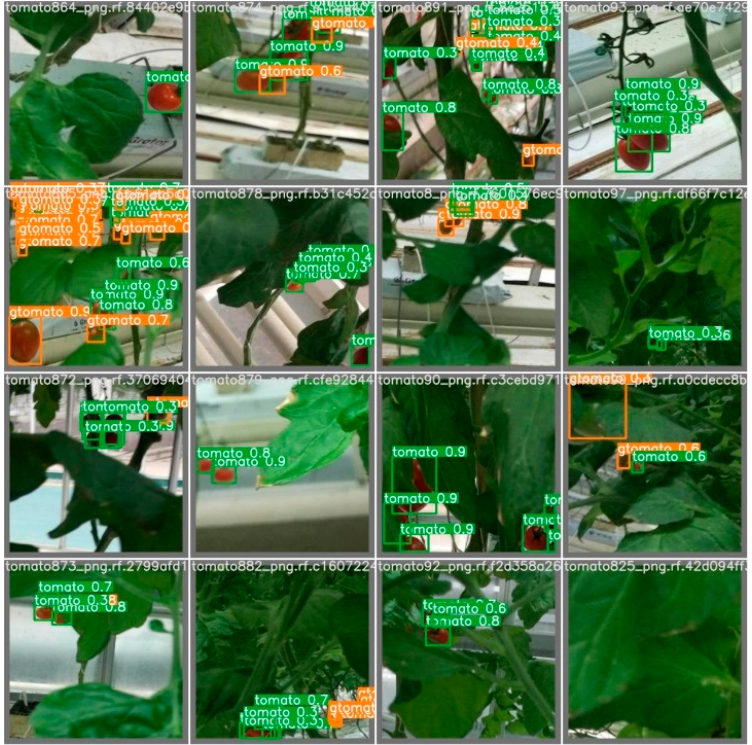
Figure 11. Obtained test results batch with accuracy for Tomato detection model. Here, green and orange colored bounding boxes represent red tomato and green tomato classes, respectively.